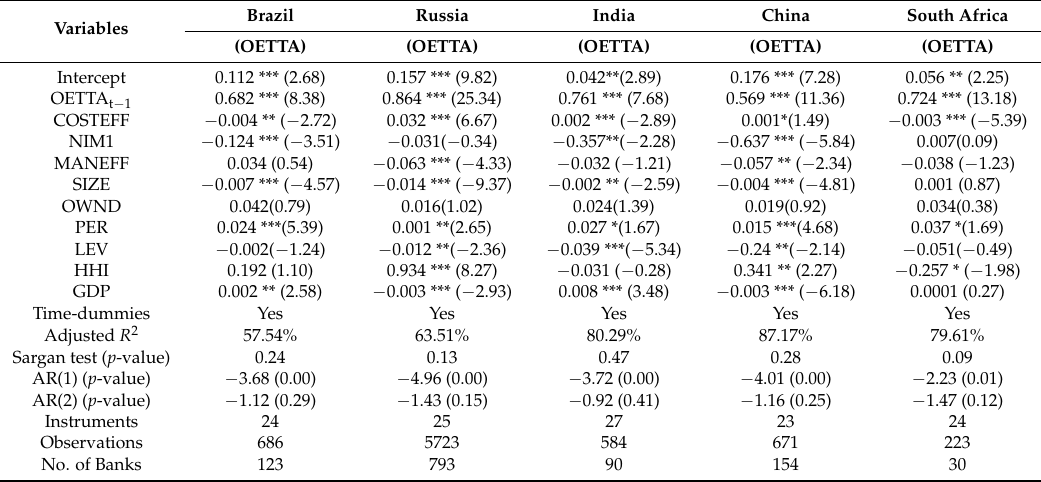
Table 8. Impact of Cost Efficiency on Bank Capital (Country-Wise